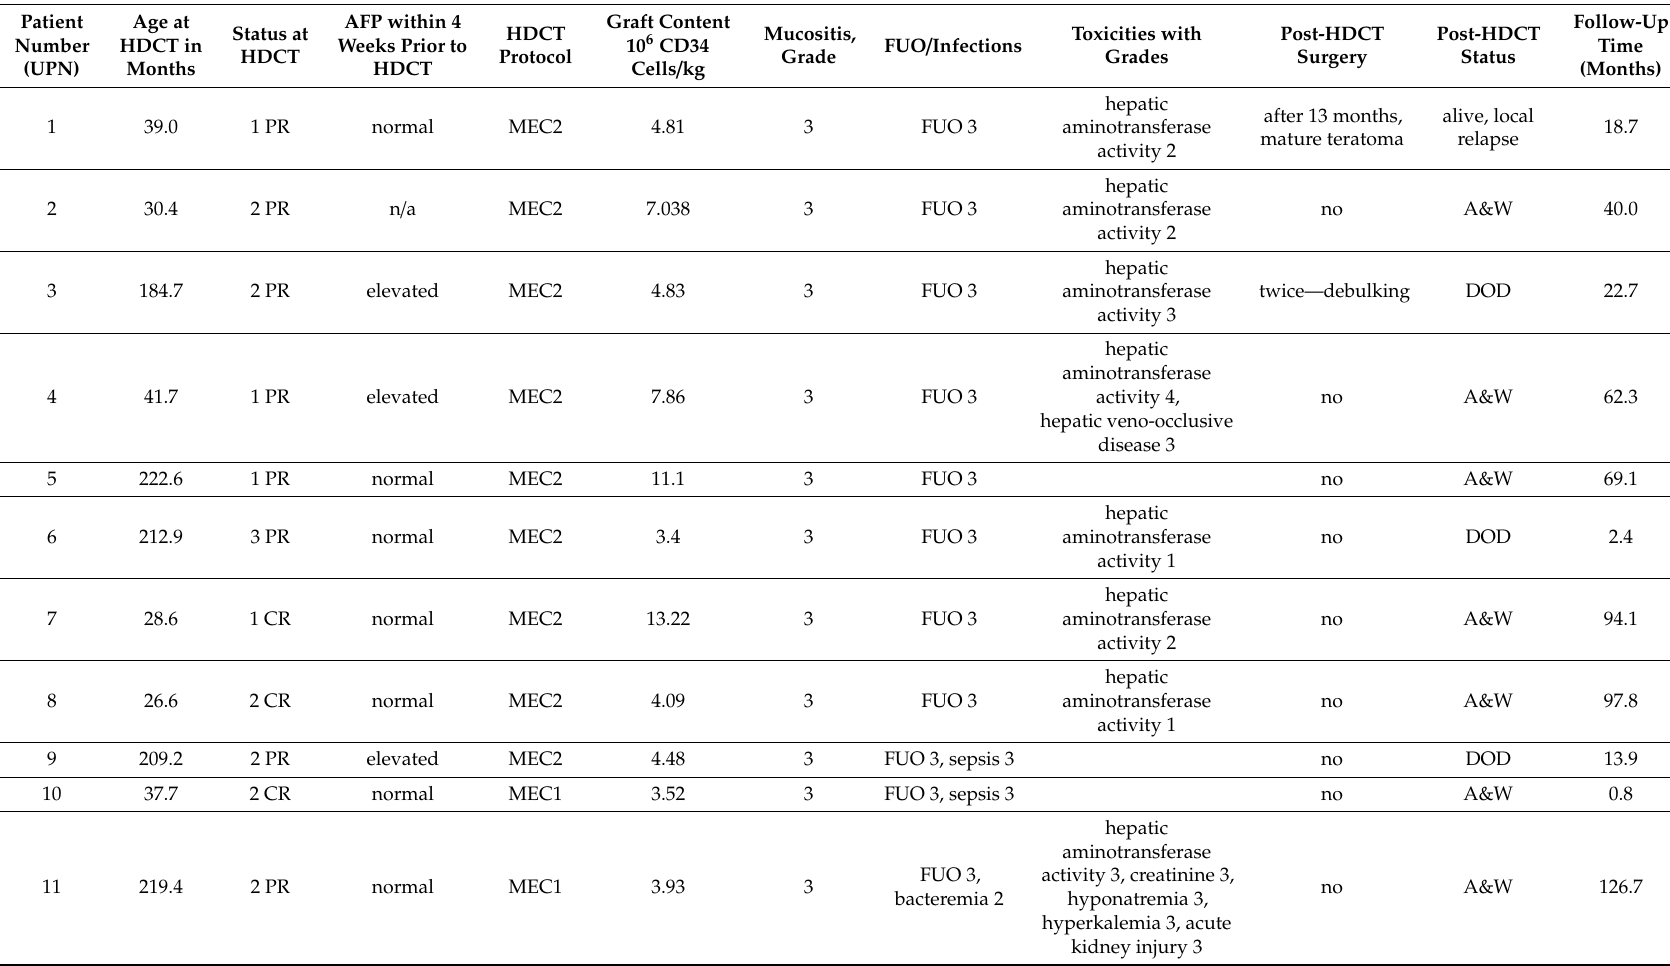
Table 2. HDCT characteristics, complications, and